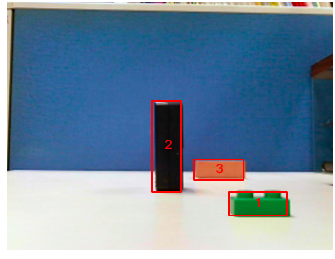
Figure 17. Labeled objects. Table 2. Estimated depth information.